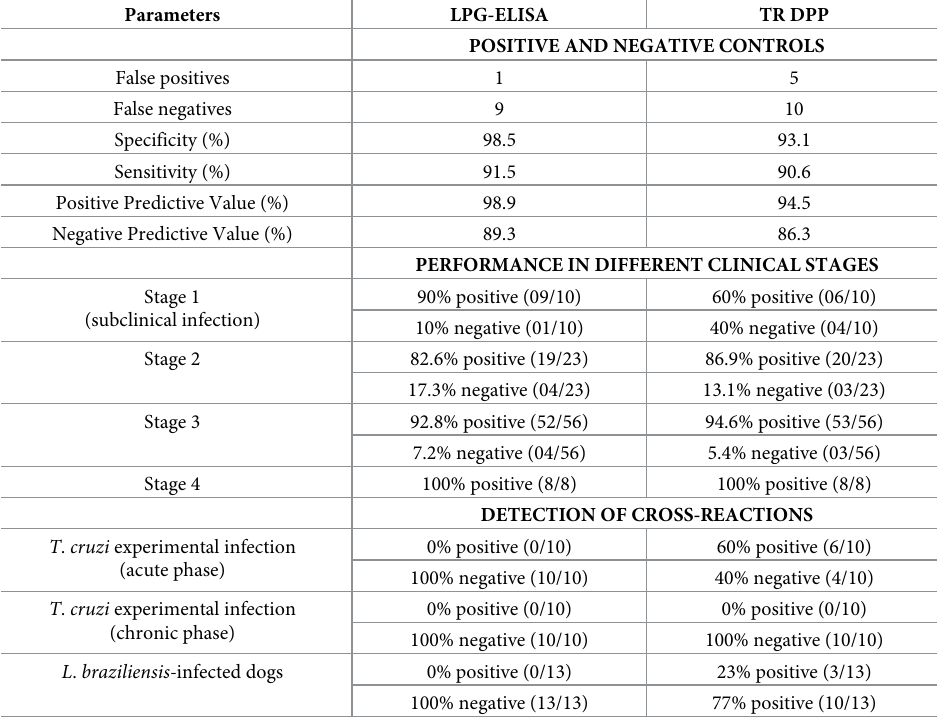
Table 3. Comparison between LPG-ELISA and TR DPP-CVL immunochromatographic assay for the diagnosis of canine leishmaniasis. The same serum samples were tested in both assays. TR DPP-CVL procedures were conducted as recommended by the